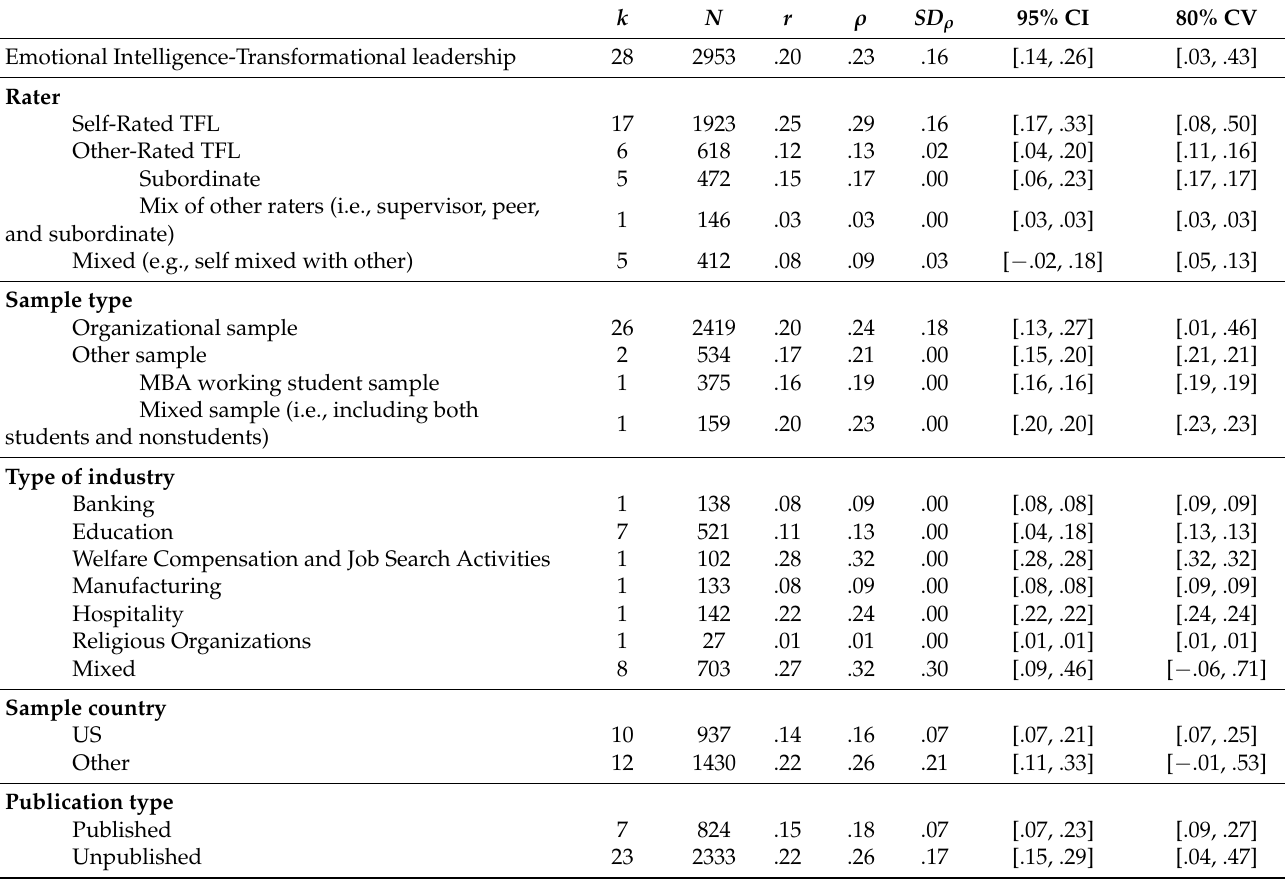
Table 2. Meta-analytic results for Emotional Intelligence and Transformational